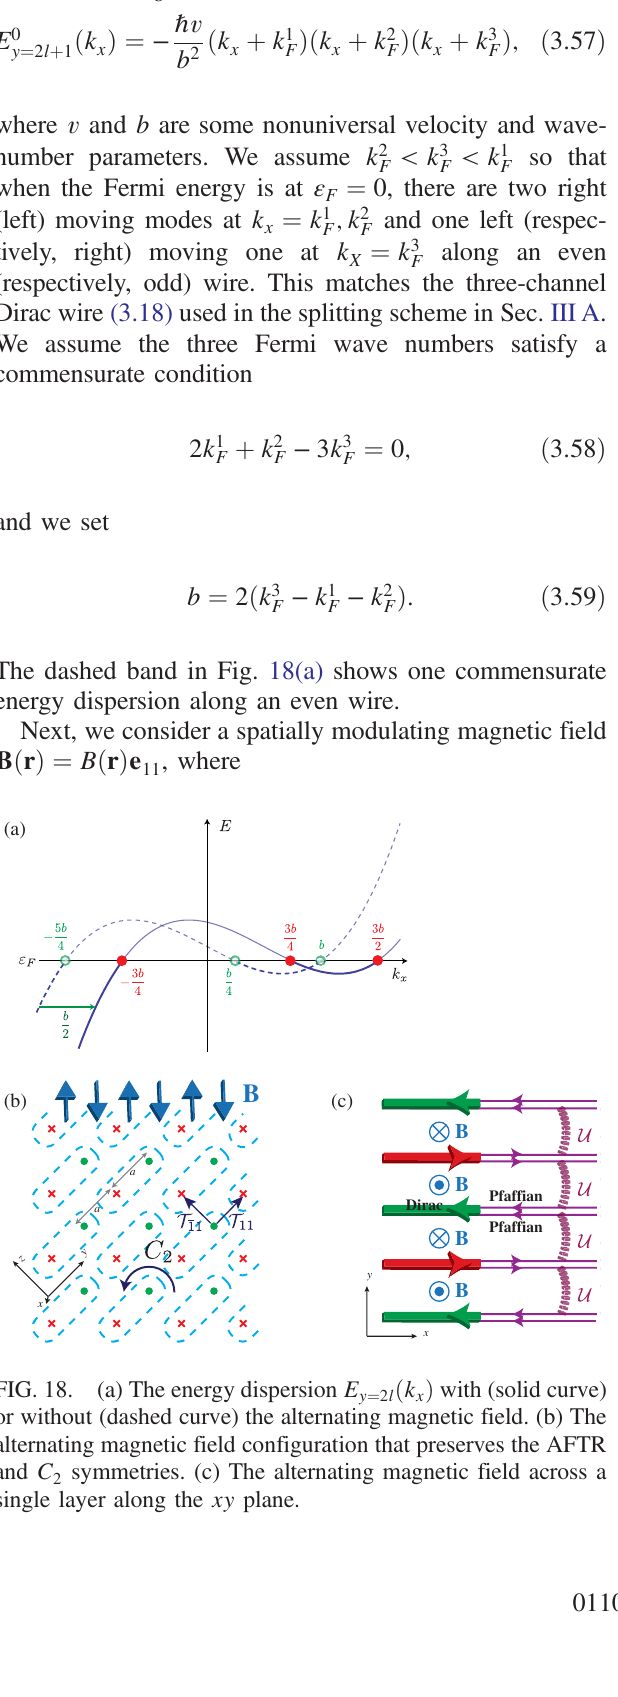
FIG. 18. (a) The energy dispersion E or without (dashed curve) the alternating magnetic field. (b) The alternating magnetic field configuration that preserves the AFTR and C 2 symmetries. (c) The alternating magnetic field across a single layer along the xy